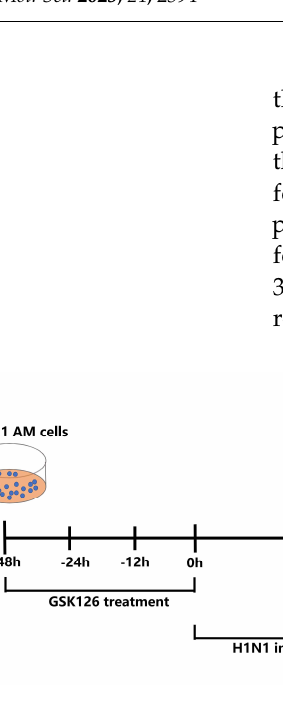
Figure 3. Inhibition of EZH2 remarkably reduces IAV infection in porcine 3D4/21 AM cells. ( A ) Scheme for the H1N1 influenza A virus infection after GSK126 treatment and subsequent experi- ments on the porcine 3D4/21 AM cells. ( B ) qRT-PCR confirmed the reduced expression abundance of the H1N1 M gene after treatment of the 3D4/21 AM cells with the EZH2 inhibitor GSK126. ( C ) Western blotting confirmed the reduced protein abundance of the H1N1 NP protein after treatment of the 3D4/21 AM cells with the EZH2 inhibitor GSK126. GAPDH in the bottom panel was used as control. Three biological replicates were used for each group. Data are presented as the mean ± SD. p-values were calculated by using Student’s t-test. * p < 0.05.